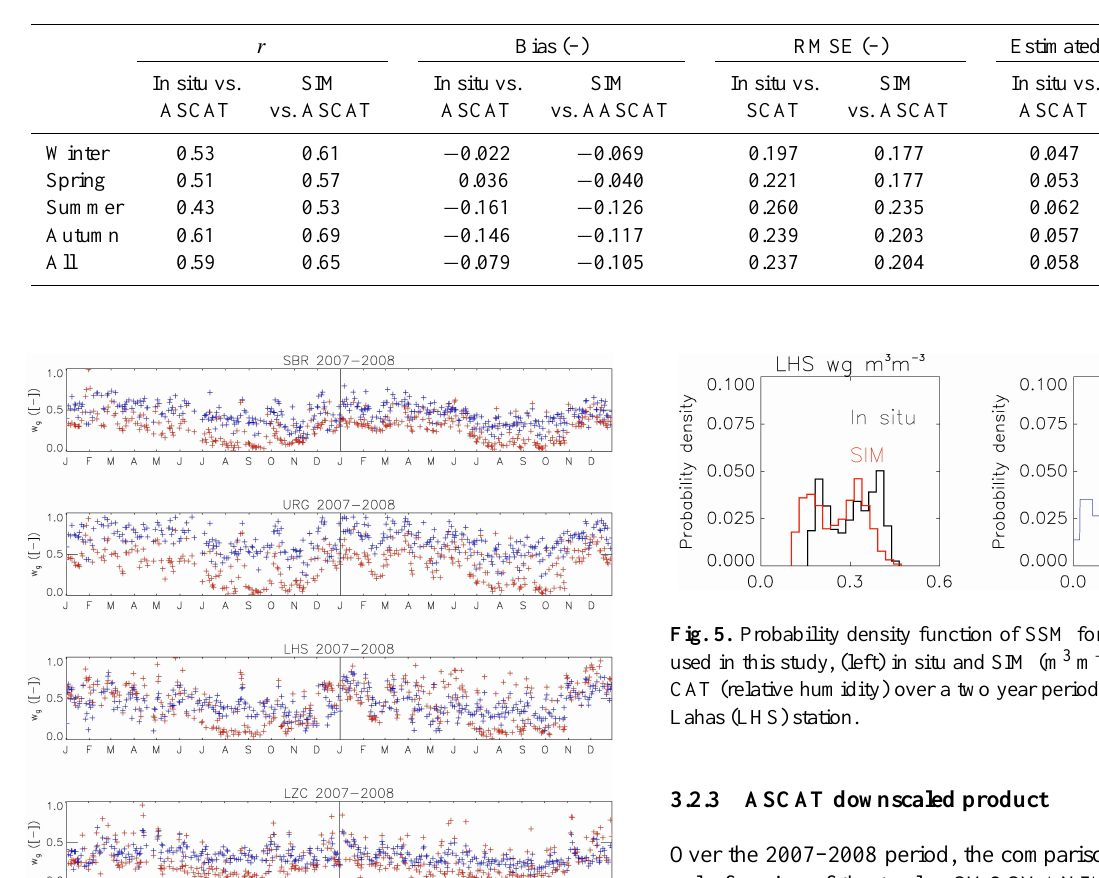
Table 4. Averaged seasonal statistical scores for 11 stations of the SMOSMANIA network and for the SMOSREX site for the comparison between (i) ASCAT vs. in situ (5cm) SSM and (ii) ASCAT vs. SIM SSM over a two year period.